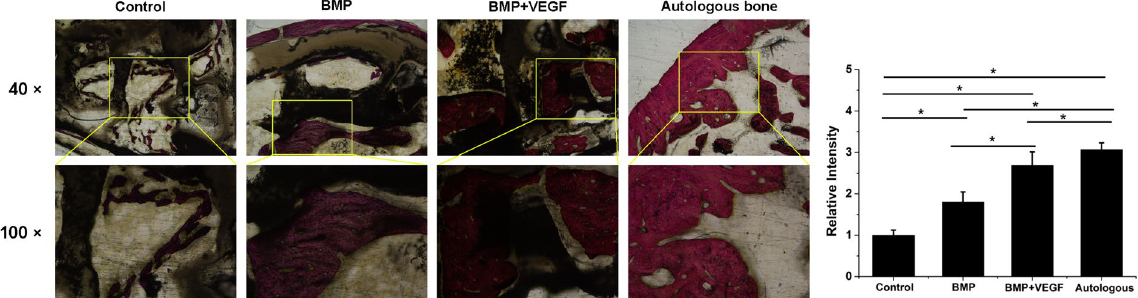
Figure 12. The VG staining of newly formed bone in the middle part inside the implanted scaffolds/ autogenous bone of the four groups with relevant statistics analysis. The lower images were magnified from the corresponding